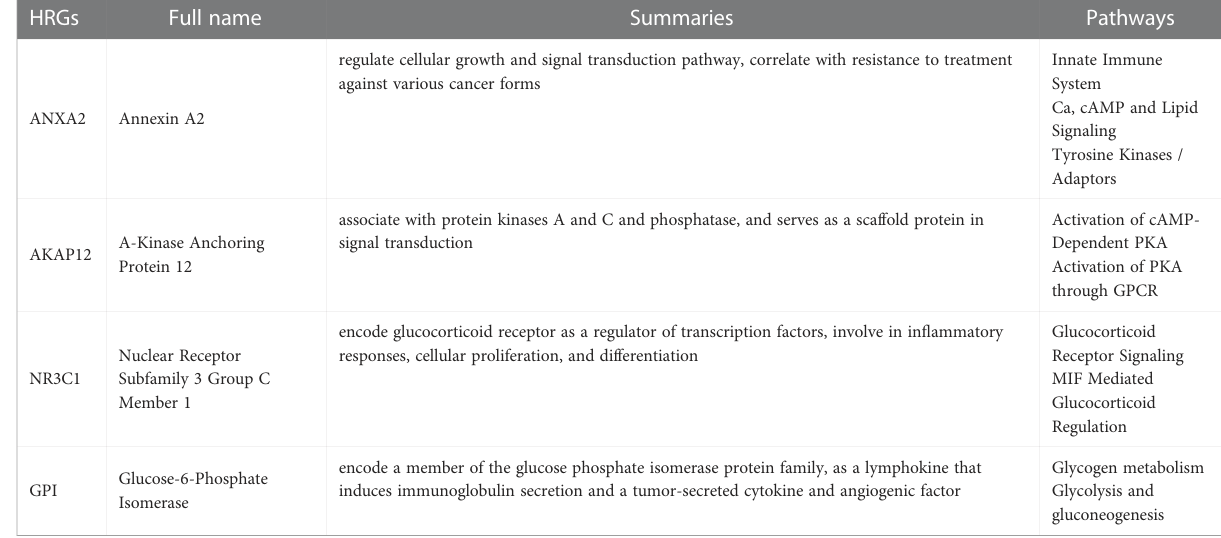
TABLE 3 The full name, summaries and pathways of 4 hypoxia-related genes (HRGs) in endometrial carcinoma.